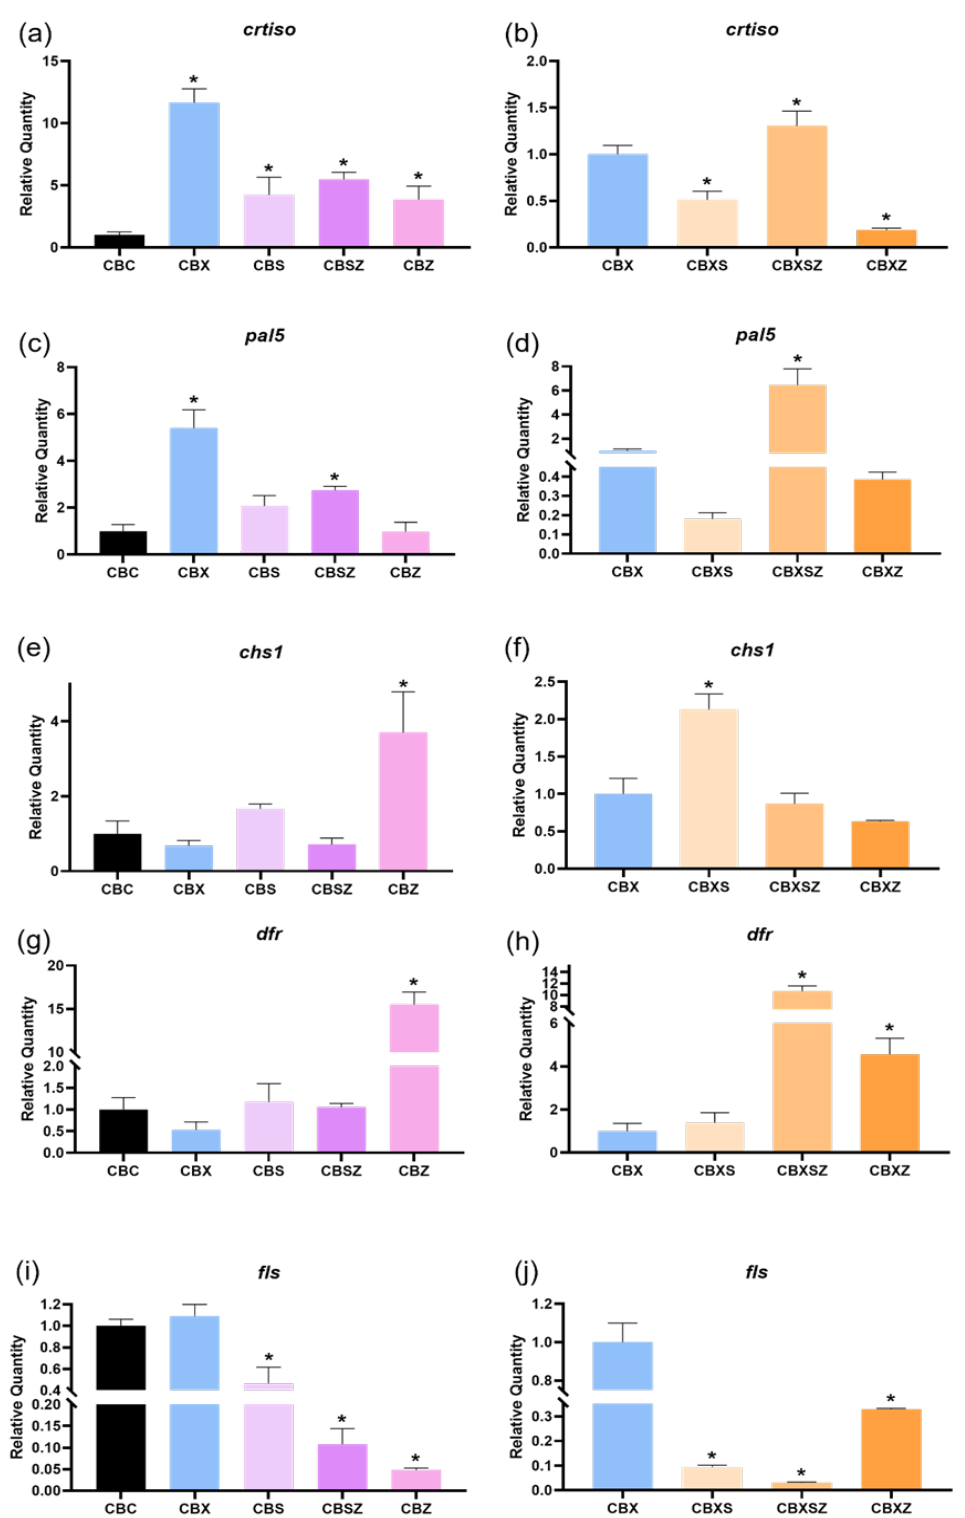
Figure 7. Expression levels of genes related to the carotenoid ( crtiso ) and phenylpropanoid ( pal5 ; chs1 ; dfr ; fls ) pathways 10 days after treatments. Relative expression levels were determined by q-PCR. ( a , c , e , g , i ) represent the uninfected/treated groups (CBS; CBSZ; CBZ) and the infected/untreated control (CBX) normalized to the negative control (CBC). ( b , d , f , h , j ) represent the infected/treated groups (CBXS; CBXSZ; CBZ) compared to the positive control (CBX). Values are presented as mean ± standard deviation. All values marked with an asterisk are statistically different from the respective control following the Dunnett comparison test ( p < 0.05).